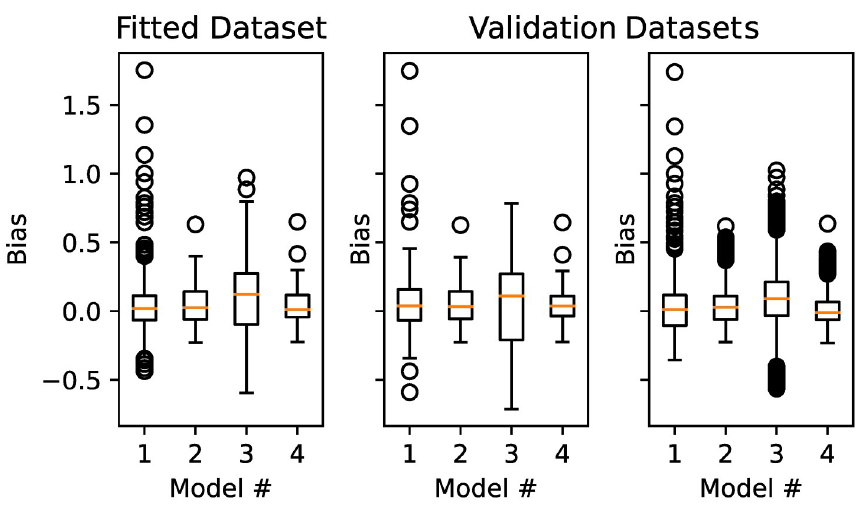
Fig 6. Boxplot of the bias distribution of the μ -estimator, using the four models, compared to the measured value.